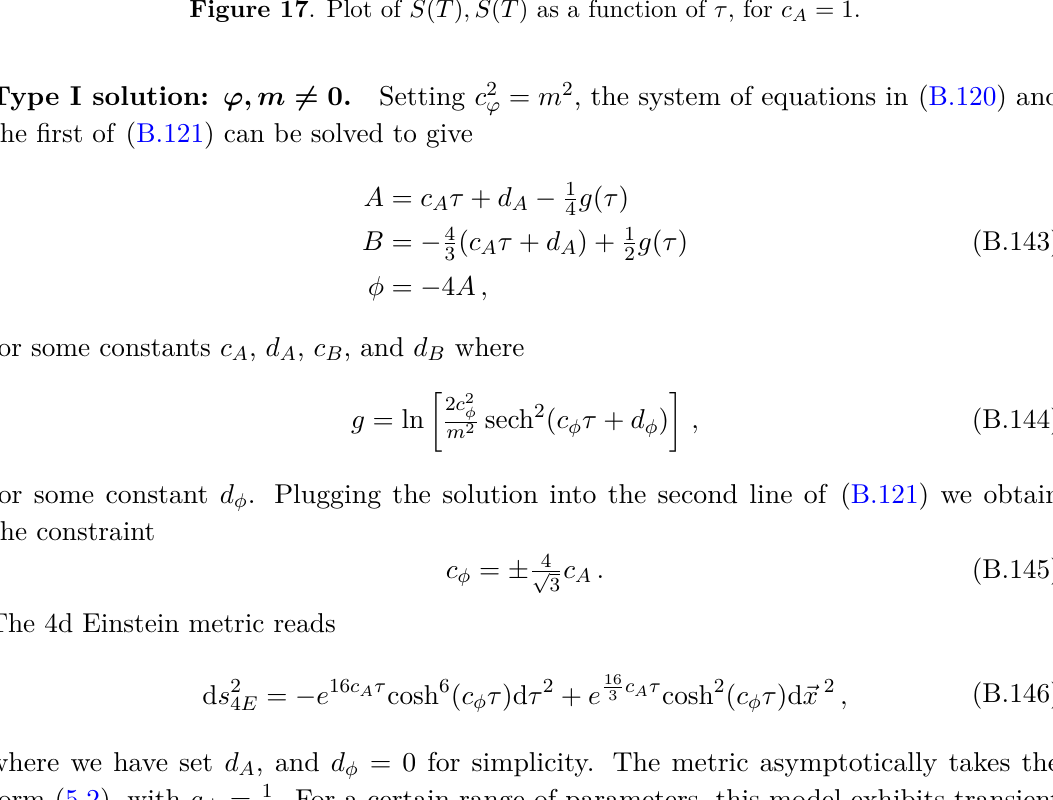
Figure 17 . Plot of